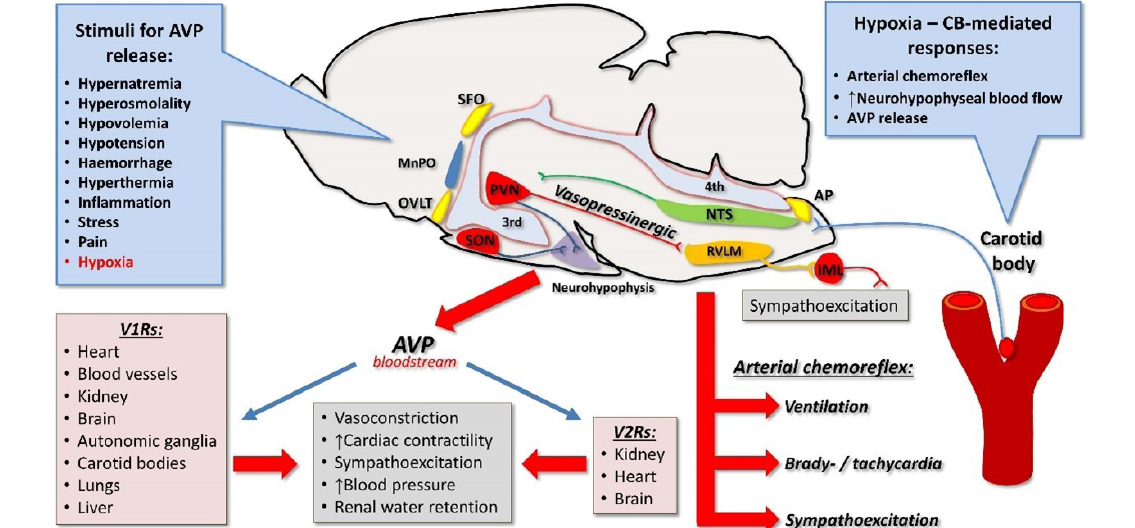
Figure 1. Vasopressin, hypoxia, and cardiovascular system. Vasopressin is released from the neurohypophysis into the bloodstream in response to numerous stimuli, including hypoxia. Carotid body-mediated responses to hypoxia depend on its connections to the CNS via NTS. These responses include activation of arterial chemoreflex, increase in neurohypophysial blood flow, and release of AVP. Vasopressin exerts its cardiovascular actions by binding to V1Rs and V2Rs. Vasopressinergic pathways from the PVN to the brainstem are activated by hypoxia and involve activation of the RVLM and sympathoexcitation. AP: